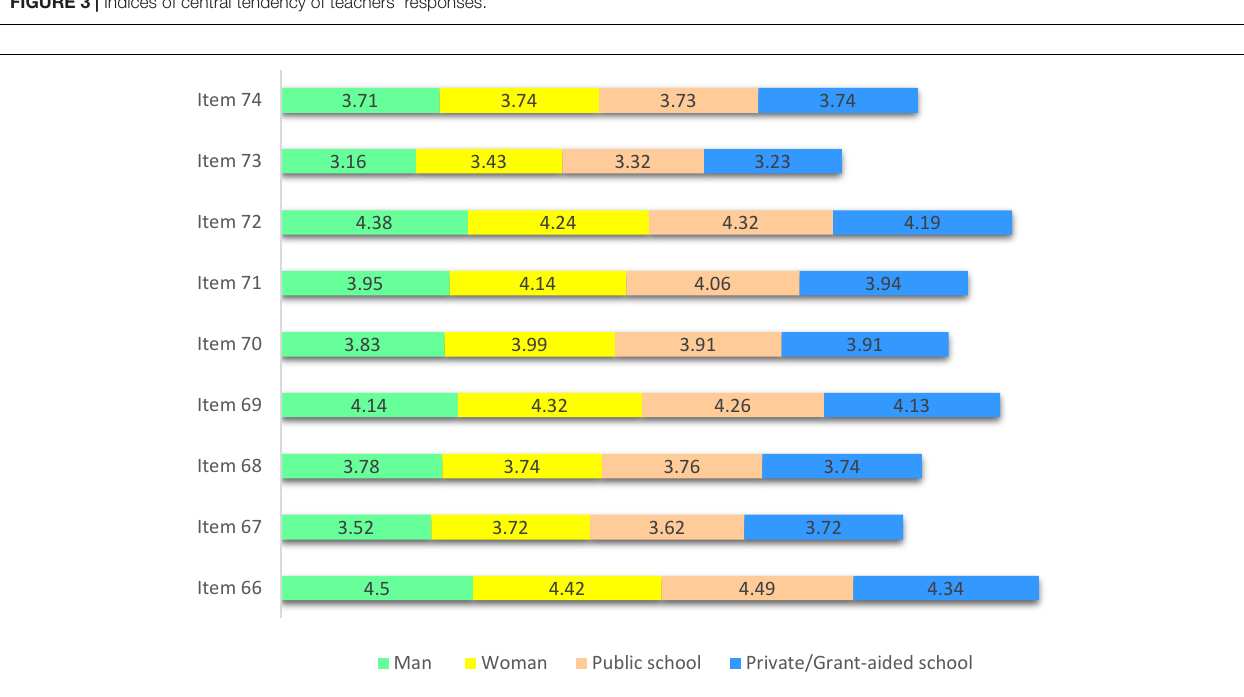
FIGURE 3 | Indices of central tendency of teachers’ responses.